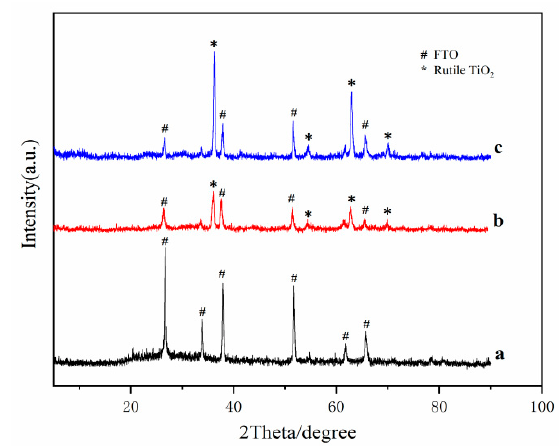
Figure 1. X-ray di ff raction (XRD) patterns of Fluorine-doped tin oxide (FTO) ( a ), TiO 2 / FTO before Figure 1. X-ray diffraction （ XRD ） patterns of Fluorine-doped tin oxide (FTO) ( a ), TiO 2 /FTO before anneal ( b ) and TiO 2 / FTO after anneal ( c ). anneal ( b ) and TiO 2 /FTO after anneal ( c ).